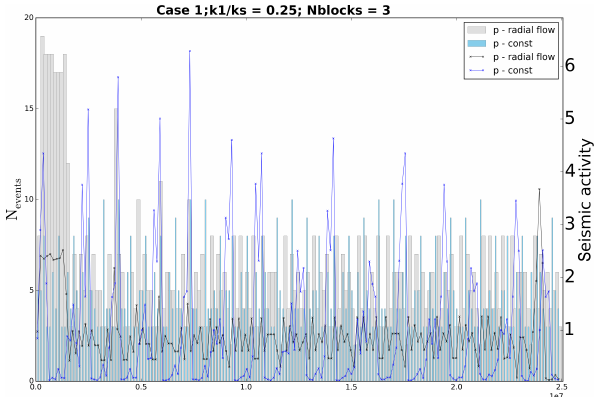
Figure 30. Time variation of seismic activity.